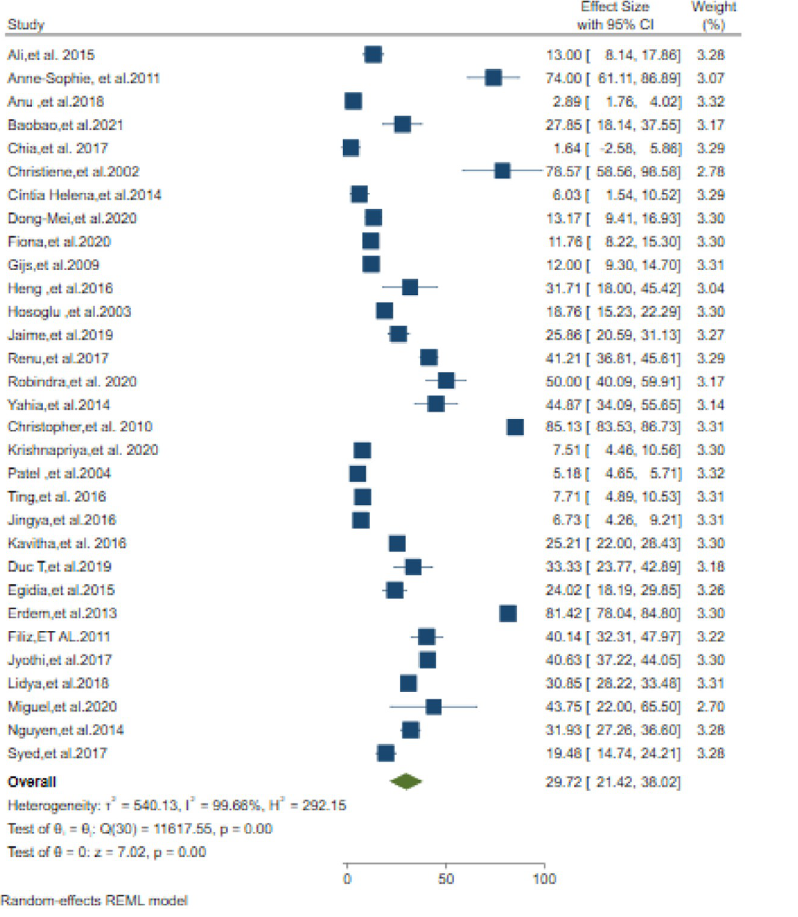
Fig 2. CSF Culture confirmed Tuberculosis meningitis among suspected